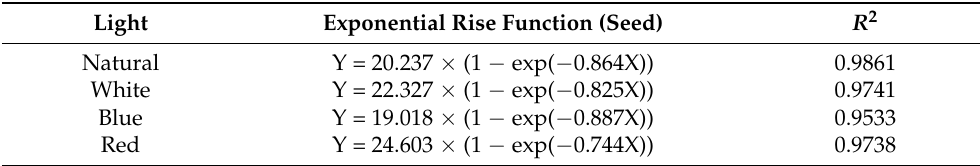
Table 1. Exponential rise to maximum with the germinated seed with the time. Light Exponential Rise Function (Seed) R 2 Natural